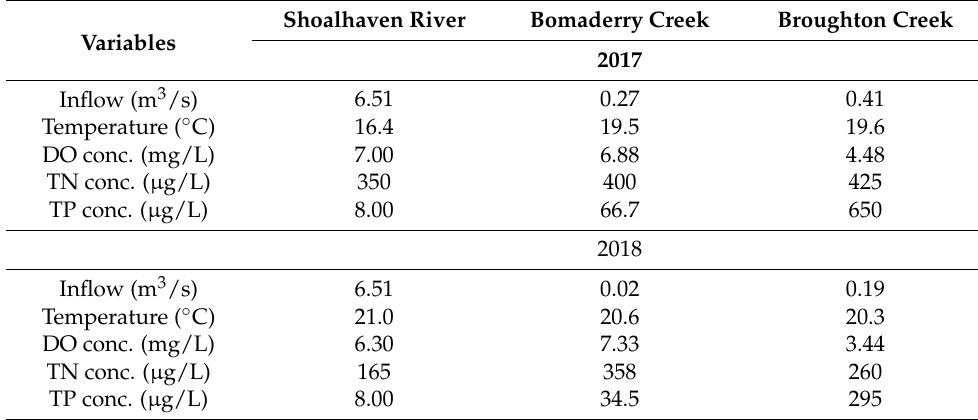
Table 1. Annual average water quality data for the Shoalhaven River inflow and point source inputs in 2017 and 2018. Shoalhaven Variables